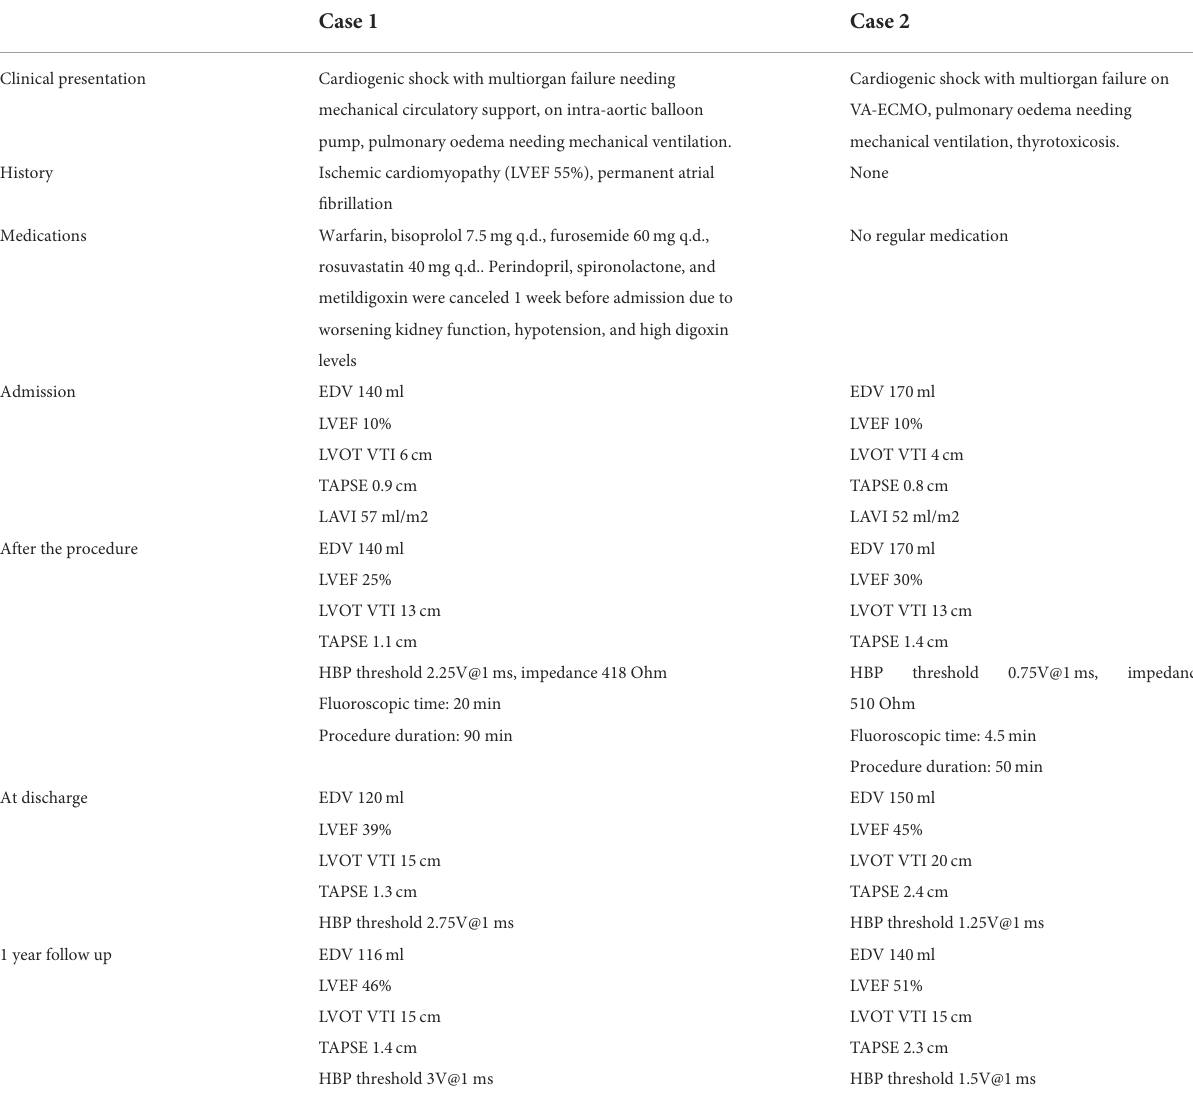
TABLE 1 Summary of clinical presentations, cardiac function, and pacing